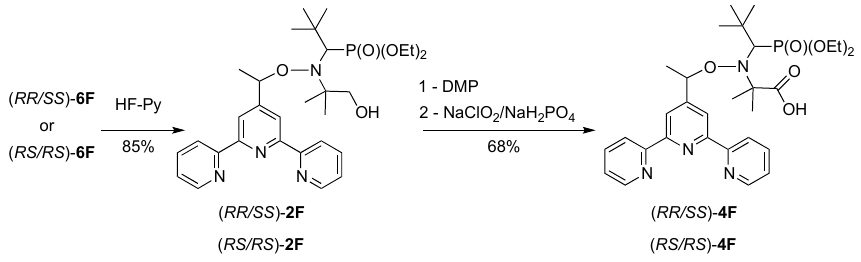
Scheme 2. Synthesis of alkoxyamines ( RR / SS )- 2F , ( RS / SR )- 2F , ( RR / SS )- 4F and ( RS / SR )- 4F .